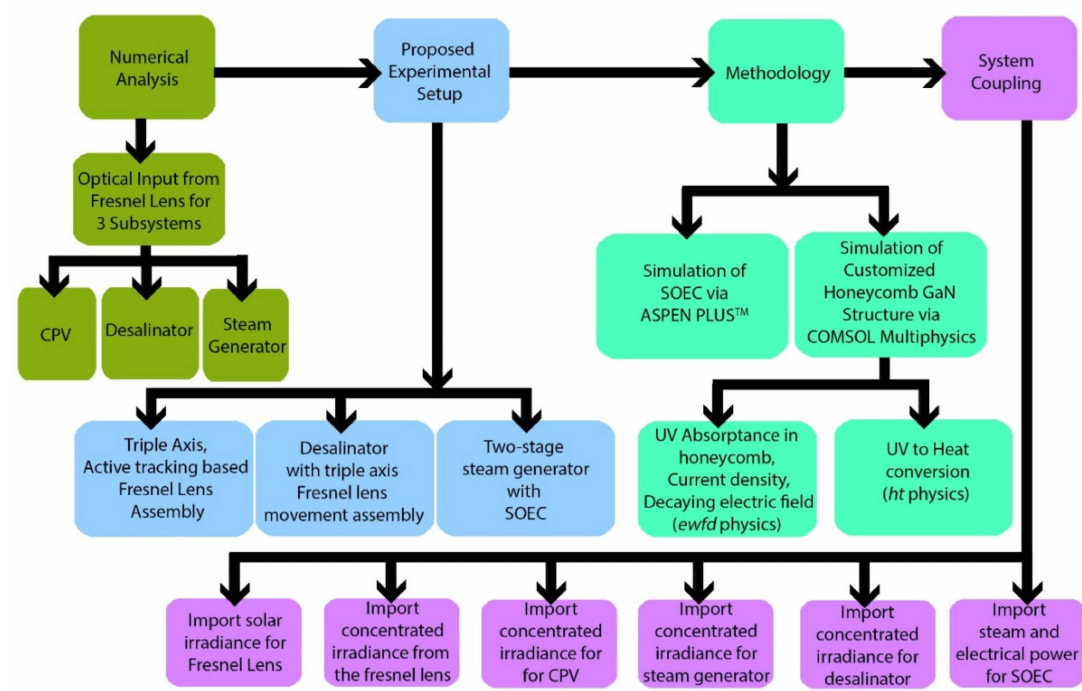
Figure 2. The schematic framework of the overall research of this